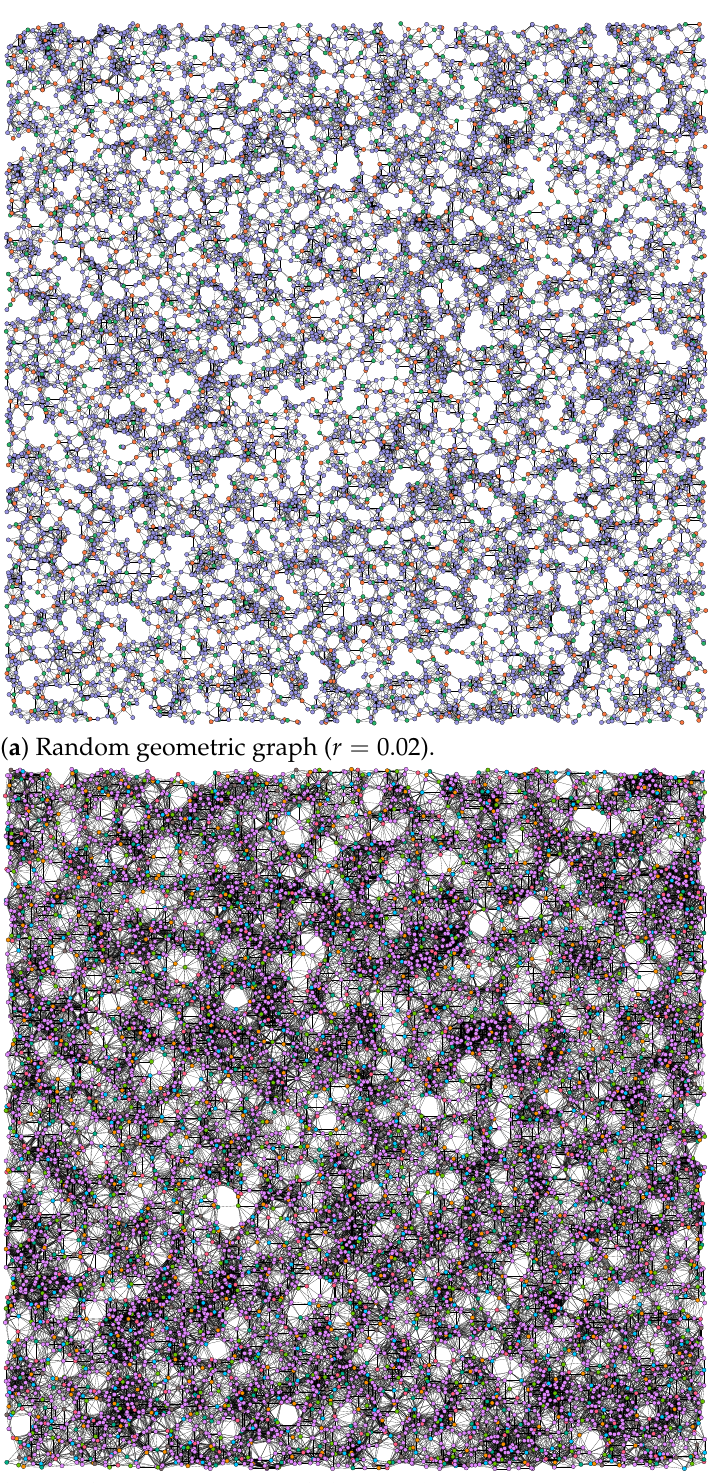
Figure 3. Results of GH-MWDDS for two random geometric graphs of different